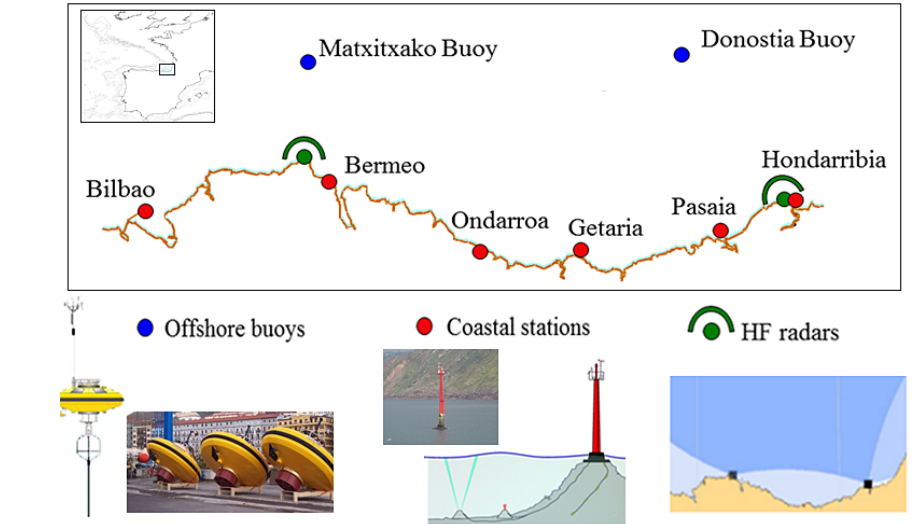
Figure 1. Oceano-meteorological Basque government